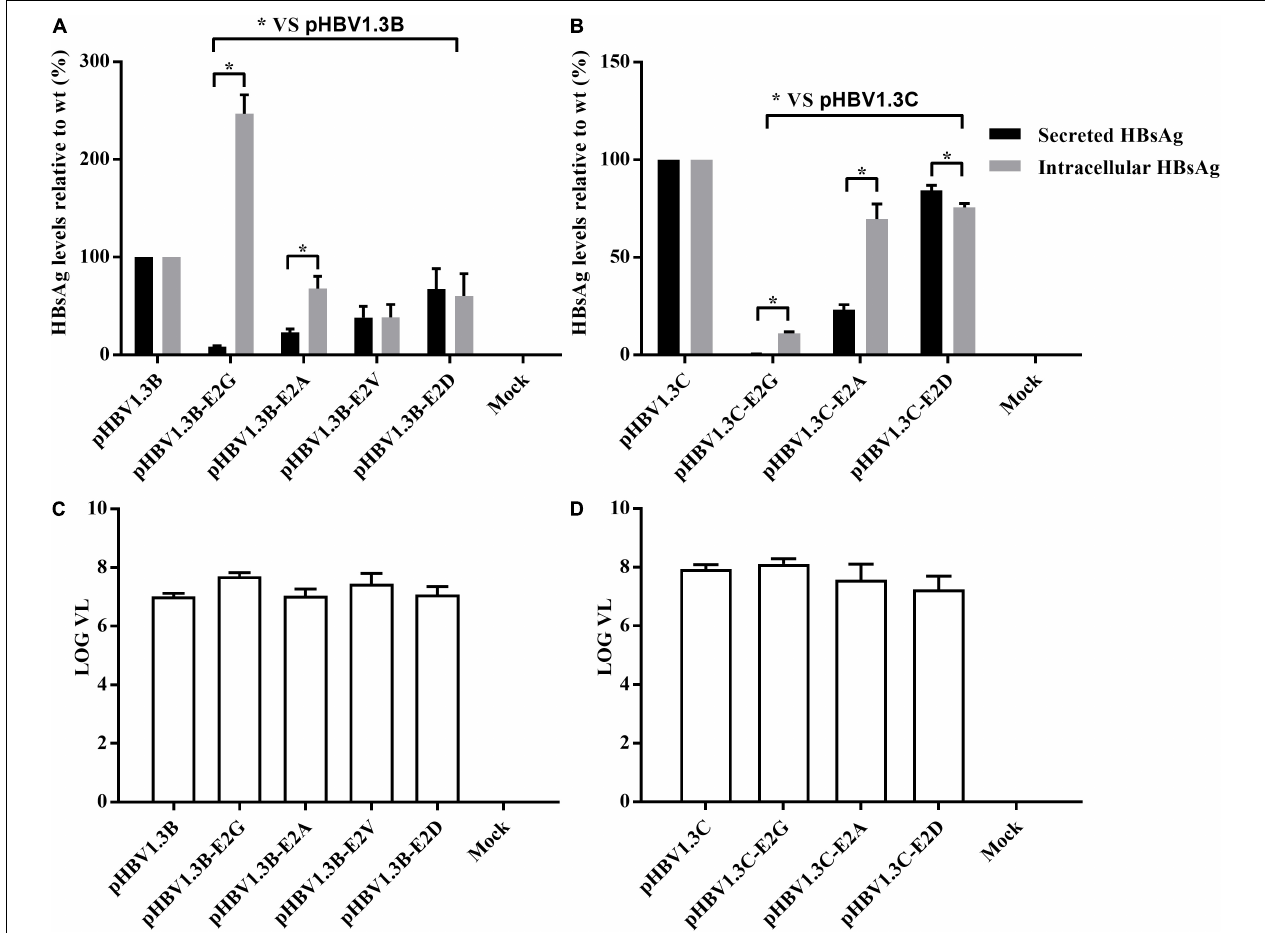
FIGURE 1 | Analysis of HBsAg and HBV DNA production by electrochemiluminescence and real-time PCR. (A,B) Extracellular and intracellular HBsAg production in HepG2 cells transfected with E2 mutant plasmids (pHBV1.3B/C-E2N) and pHBV1.3B/C. The relative expression of extracellular and intracellular HBsAg in pHBV1.3B/C-E2N was compared with that of genotype-matched pHBV1.3B/C. Data are demonstrated as means ± SD from three independent experiments. * p < 0.05. Mock: pcDNA3.1(+) vector. (C,D) Quantitation of supernatant HBV DNA with real-time quantitative PCR. pHBV1.3B/C-E2N and pHBV1.3B/C were transfected into HepG2 cells, and supernatants were analyzed using real-time quantitative PCR at 48 h after transfection. The quantitative results of HBV DNA levels were log transformed. Data were demonstrated as median and interquartile range from three independent experiments. Mock: pcDNA3.1(+)